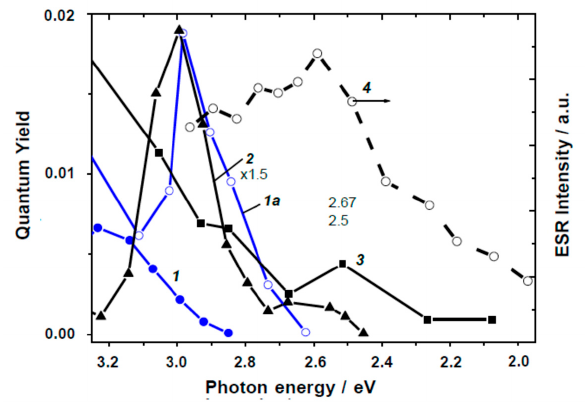
Figure 12. Spectral dependencies of the quantum yields of photostimulated adsorption of O 2 on the surface of TiO 2 specimens: Degussa P25 pre-treated at 600 K (Curve 1 ) and at 850 K (Curve 1a ) [82], rutile (Aldrich) pretreated at 600 K (Curve 2 ) [82], rutile pretreated at 820 K (Curve 3 ) [80]. Spectral dependence of the photogeneration of O 2 −• species at 77 K on the surface of rutile reduced by a H 2 heat treatment at 773 K (Curve 4 ) [81].